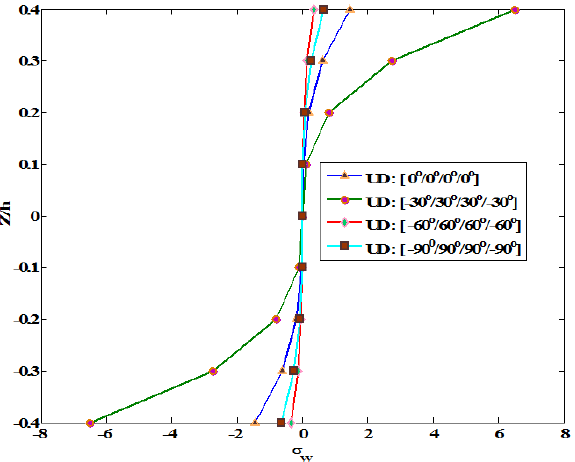
Figure 11: The non-dimensional stress σ yy for angle–ply [- θ / θ / θ /- θ ] FG-V SWCNT-FG plate with different lamination scheme